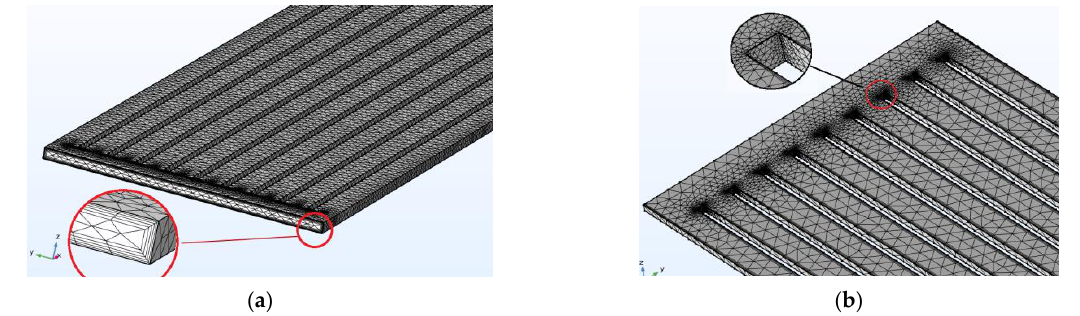
Figure 3. Grid mesh diagram of the straight fin model. ( a ) The boundary layer; ( b ) The edge of the corners.